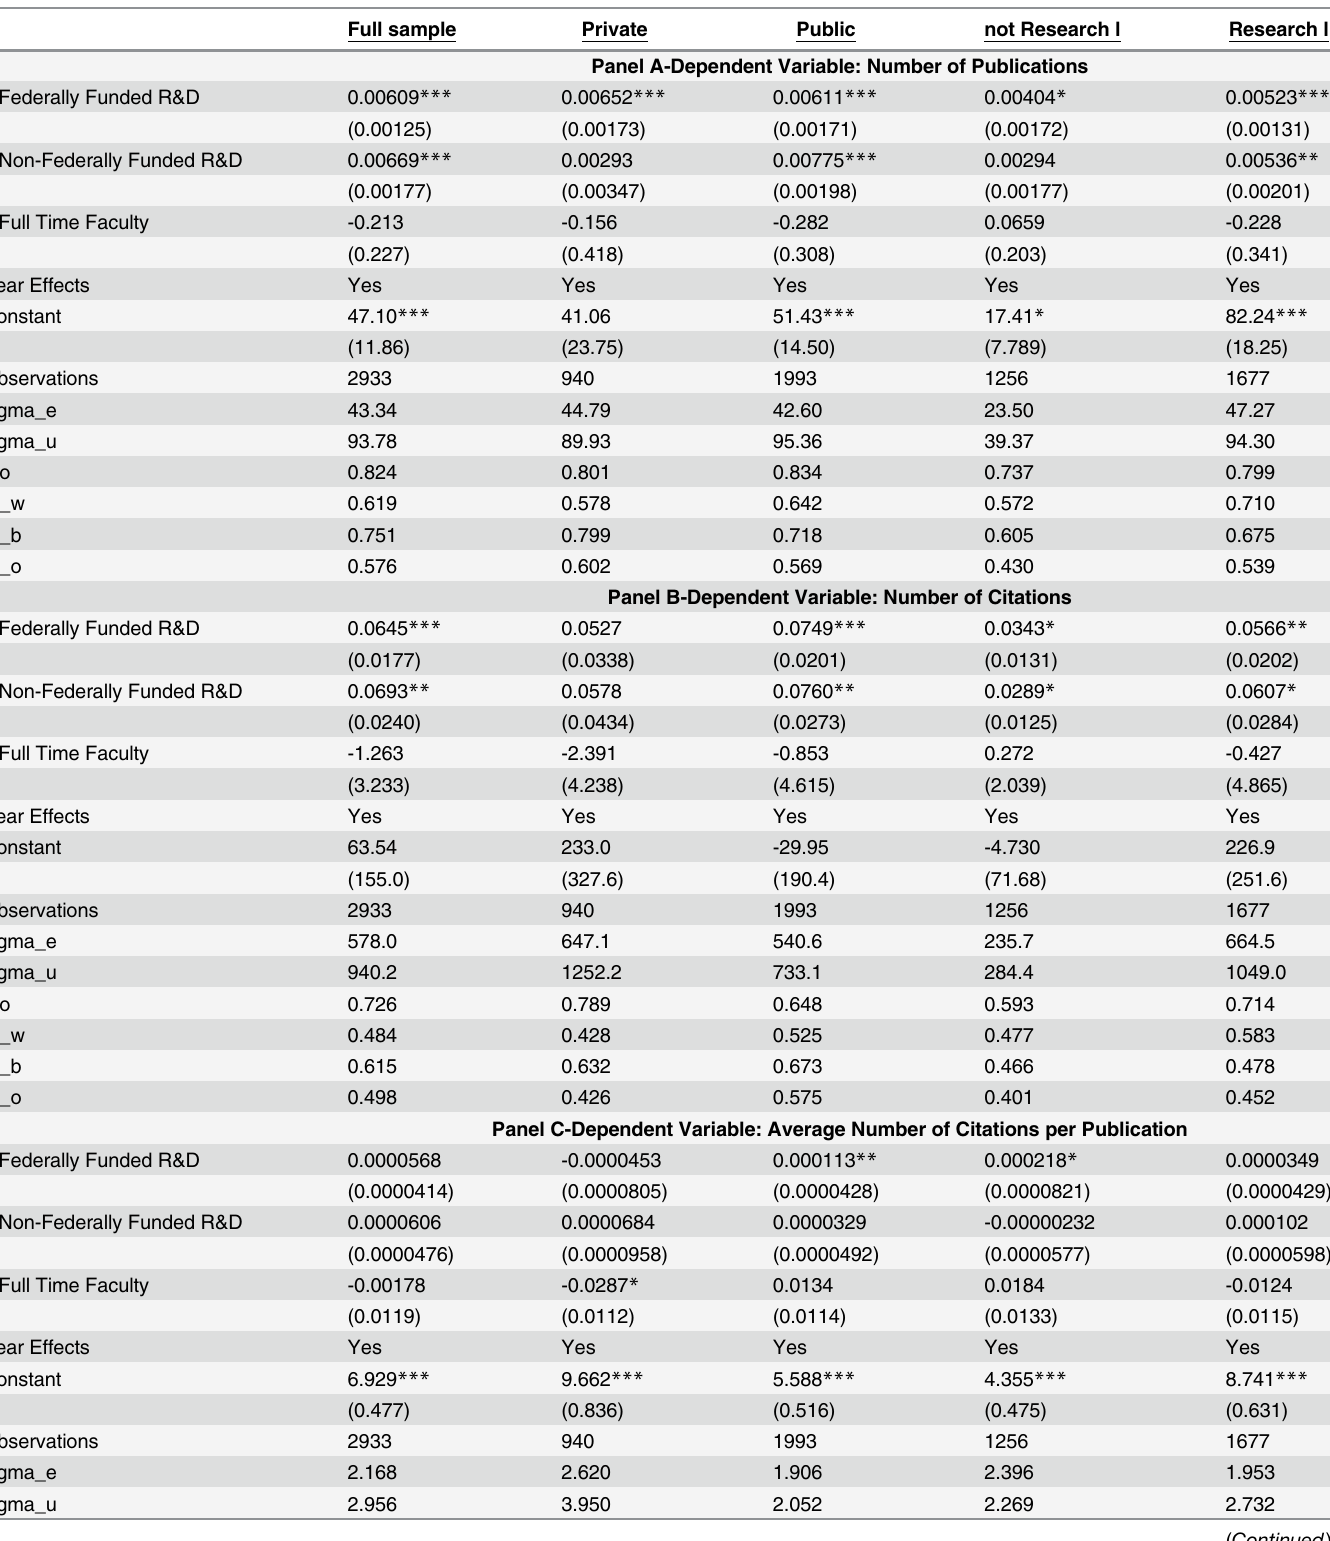
Table 3. OLS Panel Regressions. Determinants of Publications, Citations, and Average Citations per Publication, by University Type. Full